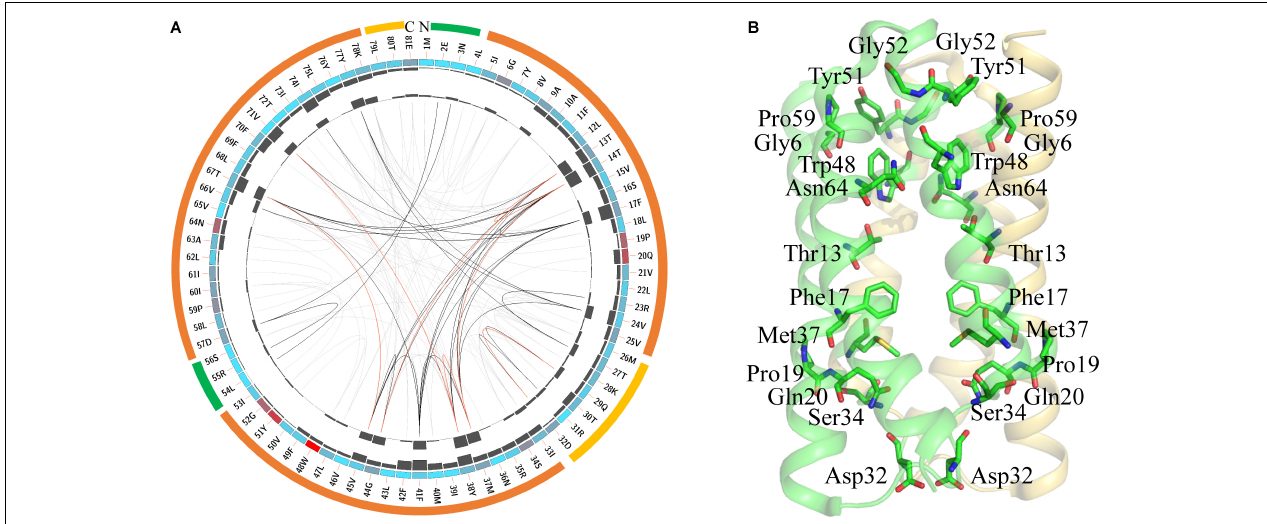
FIGURE 2 | Conserved amino acid residues in SemiSWEETs represented using LbSemiSWEET as a reference sequence. (A) Network analysis of conserved and coevolving residues. The circular network shows the connectivity of coevolving residues. The first circle represents the TM helices (orange), the intrafacial region (yellow), and the extrafacial region (green). The labels in the second circle indicate the alignment position and the amino acid code of EcSWEET. The colored square boxes of the second circle indicate MSA position conservation (highly conserved positions are in red, whereas less conserved positions are in blue). The third and fourth circles show the proximity mutual information (MI) and cumulative MI (cMI) values as histograms, facing inward and outward, respectively. In the center of the circle, the edges that connect pairs of positions represent a significant MI value ( > 6.5), highlighted in red lines with higher MI scores (top 5%), black lines (between 70 and 95%), and gray lines (the remaining 70%), as defined by MISTIC. (B) Cartoon diagram of EcSWEET (PDB ID: 4qnc) with the conserved